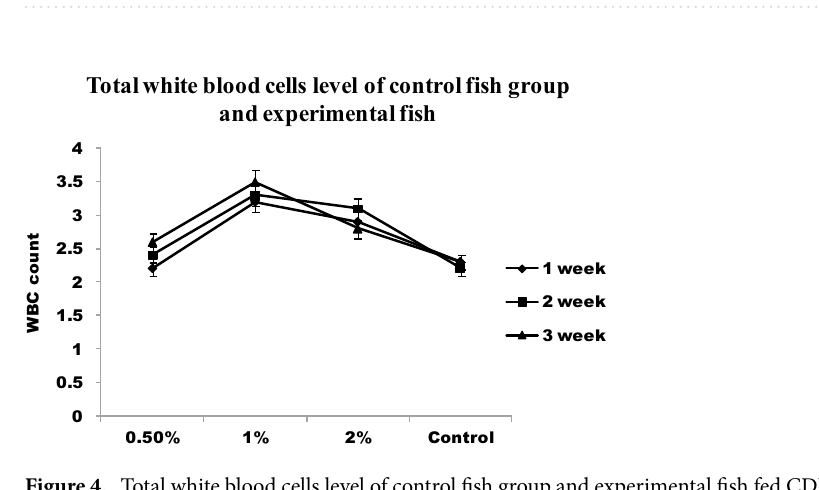
Figure 4. Total white blood cells level of control fish group and experimental fish fed CDP with basal diet.